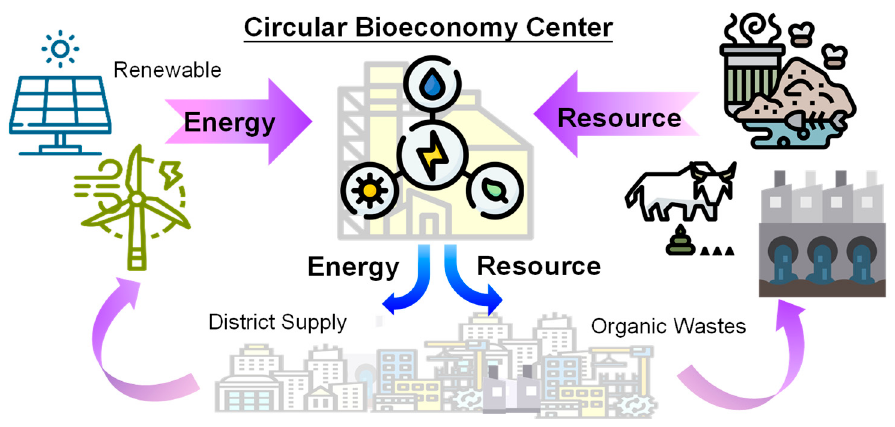
Figure 7. Concept of a circular bioeconomy to optimize and sustain the water, energy and food elements.